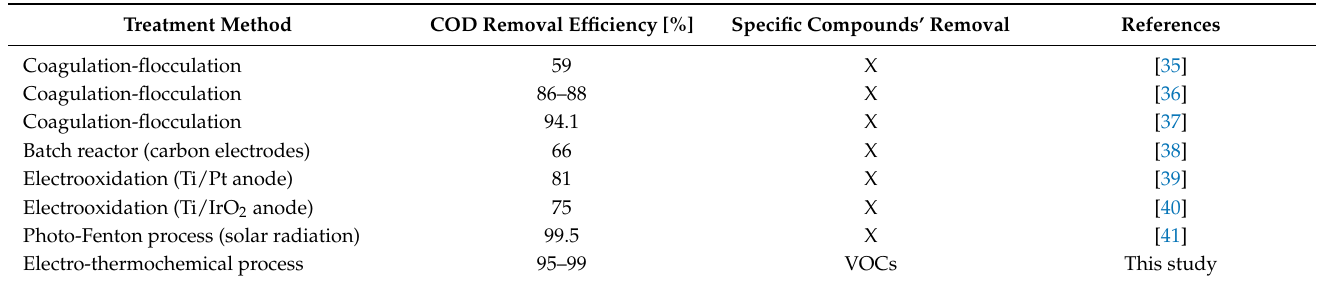
Table 2. Comparison of different treatment processes used for paint-industrial effluents.